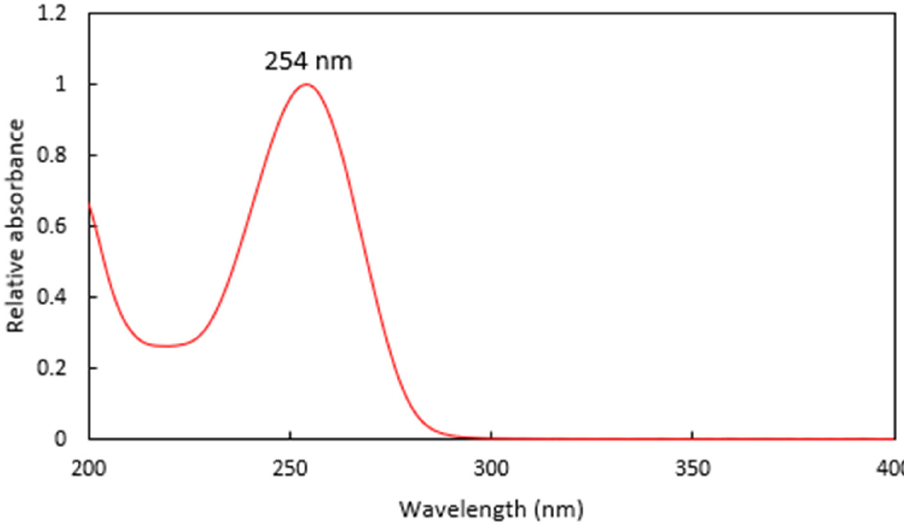
Figure 4. The UV spectra of a Regain extract, showing the λ max at 254 nm. For the analysis of linearity, the tebuthiuron standards were found to be linear over the range of 0.1–1000 mg L − 1 , with an R 2 value of 0.9999 (Figure